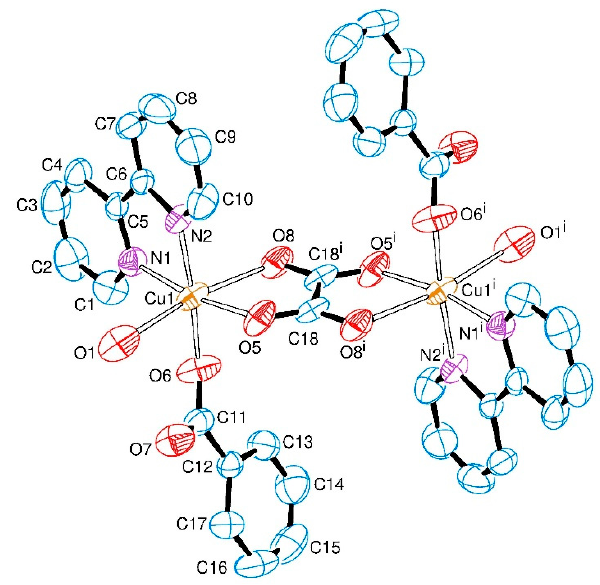
Figure 1. ORTEP representation of the [{Cu( bipy )( bzt )(OH 2 )} 2 ( µ - ox )] ( 1 ), indicating the atom numbering scheme. The hydrogen atoms were omitted for clarity. Thermal ellipsoids are drawn at the 50% probability level. Symmetry code (i): 1 − x, 1 − y, 1 − z.